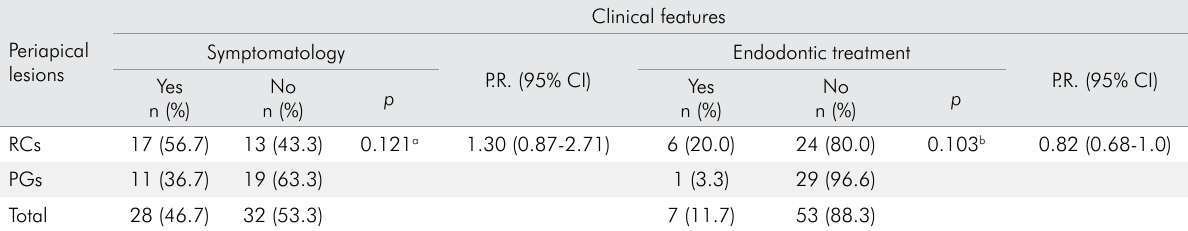
Table 3. Rates of symptomatology and endodontic treatment in chronic periapical lesions. Periapical lesions